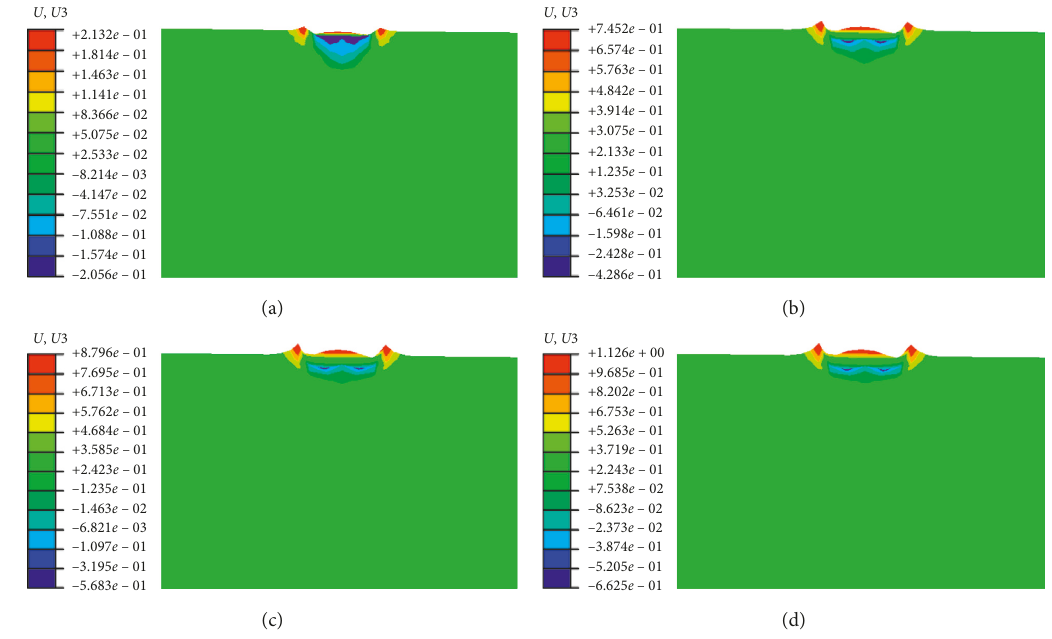
Figure 11: Vertical displacement cloud map (unit: m). (a) First strike. (b) Third strikes. (c) Fifth strikes. (d) Seventh strikes.